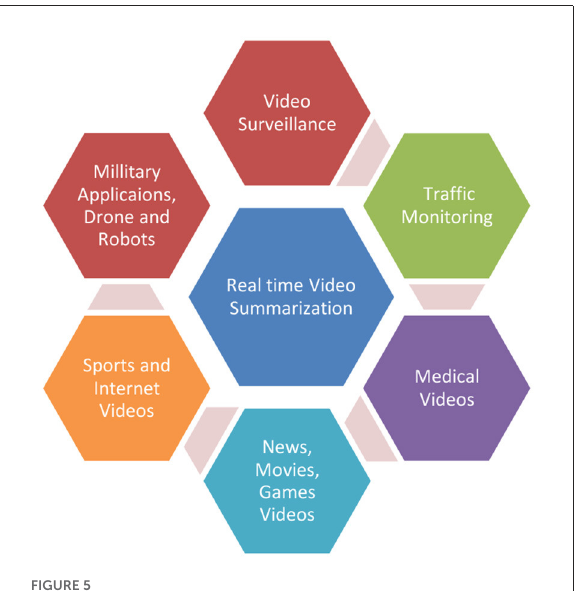
FIGURE5 Applications of real time video